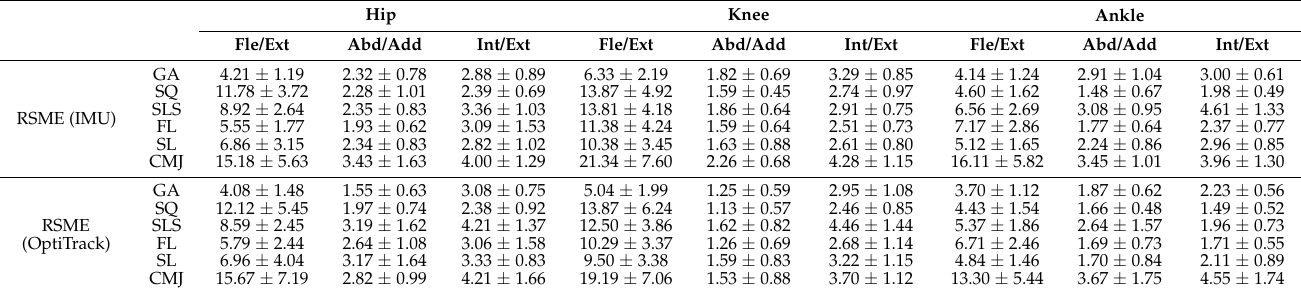
Table 2. The RMSE of IMU and OptiTrack systems collected in all